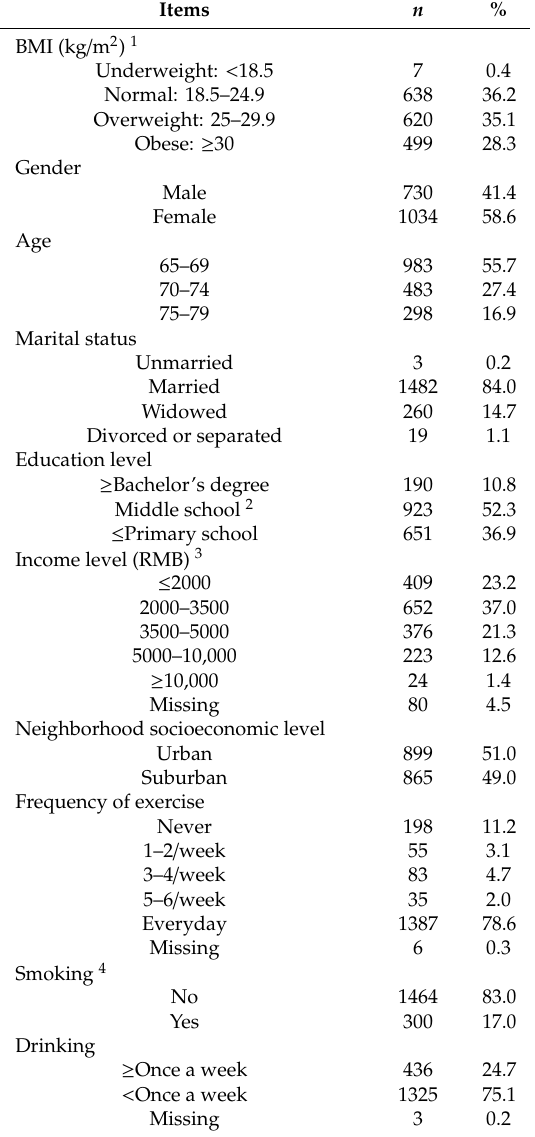
Table 1. Characteristics of the participants ( n ,